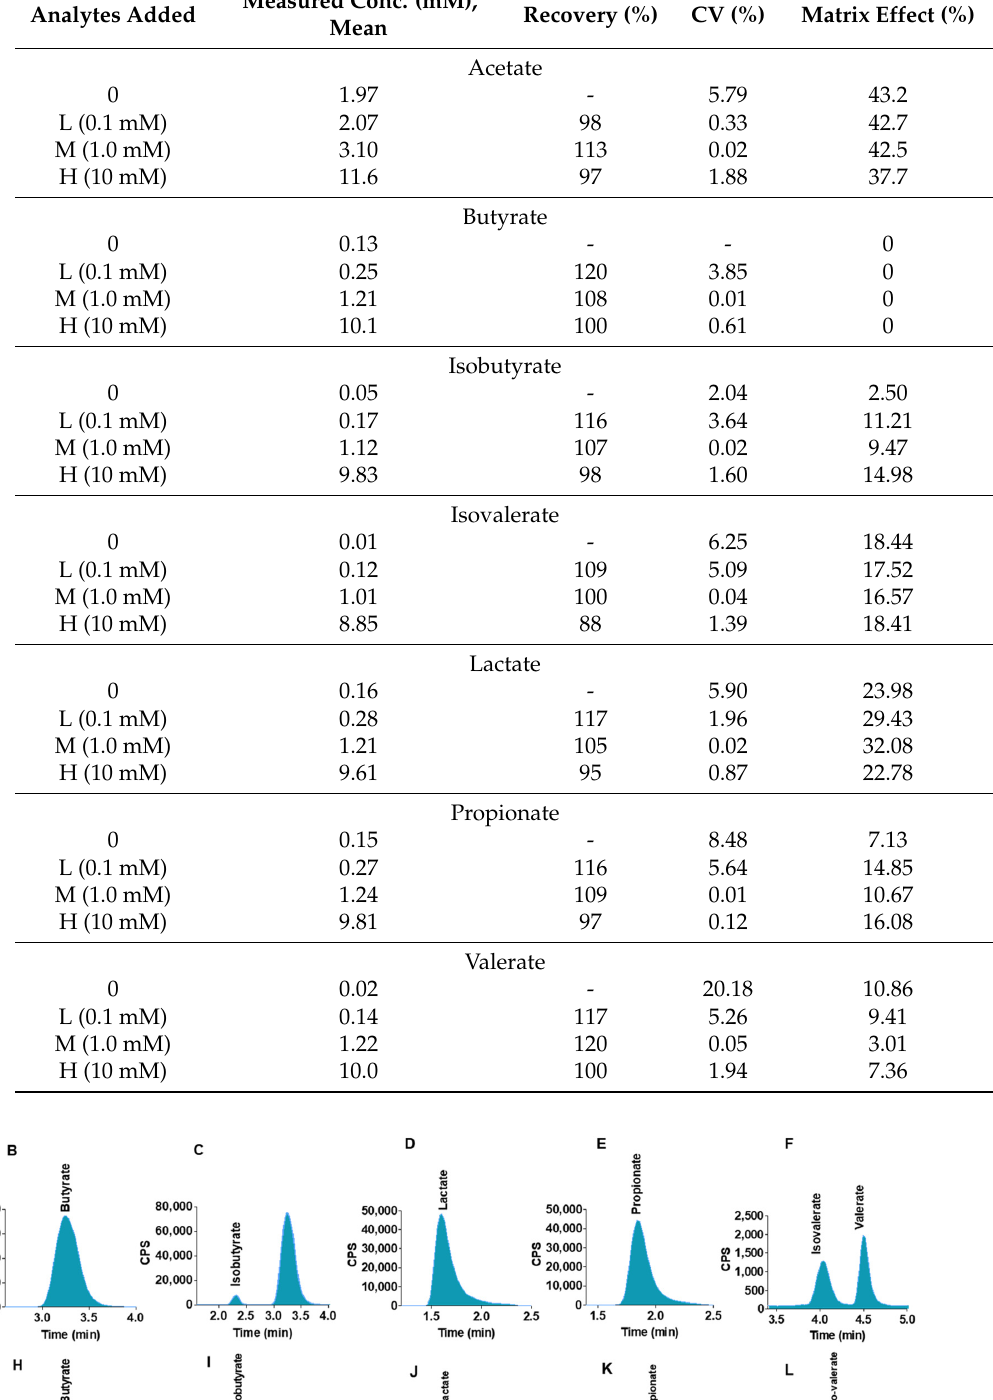
Table 4. Recovery and matrix effect of spiked individual SCFAs, BSCFAs and lactate in spiked colon models.